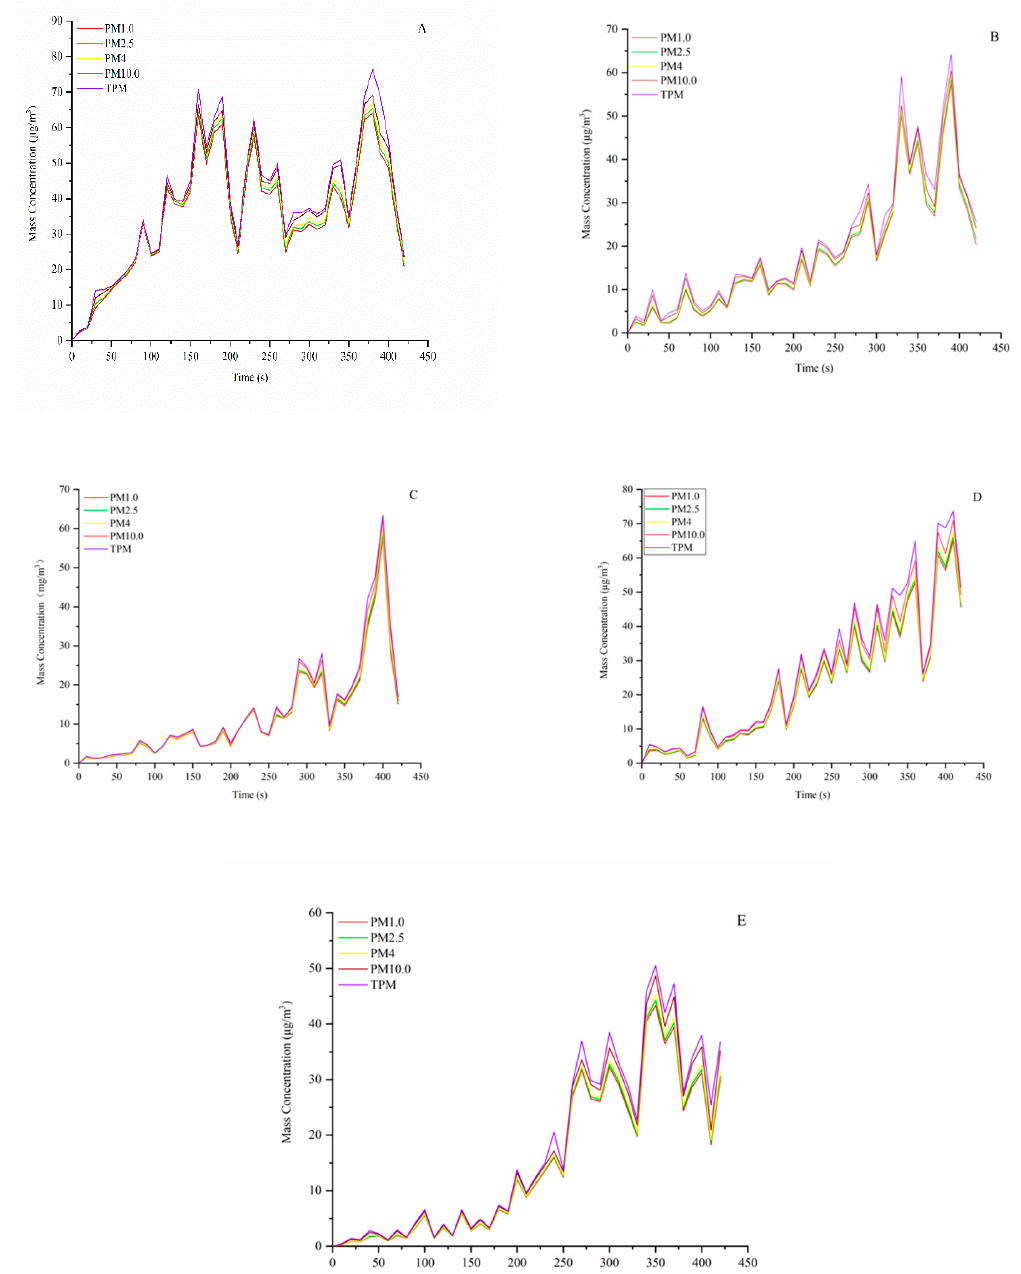
Figure 2. Measured time-dependent mass concentration of grilling-generated PM 1.0 , PM 2.5 , PM 4 , PM 10 , and TPM for four types of additives applied. The letters in the graph represent different experimental groups. ( A ) Control, ( B ) Salt group, ( C ) White pepper group, ( D ) Garlic powder group, and ( E ) Mixed spices group.